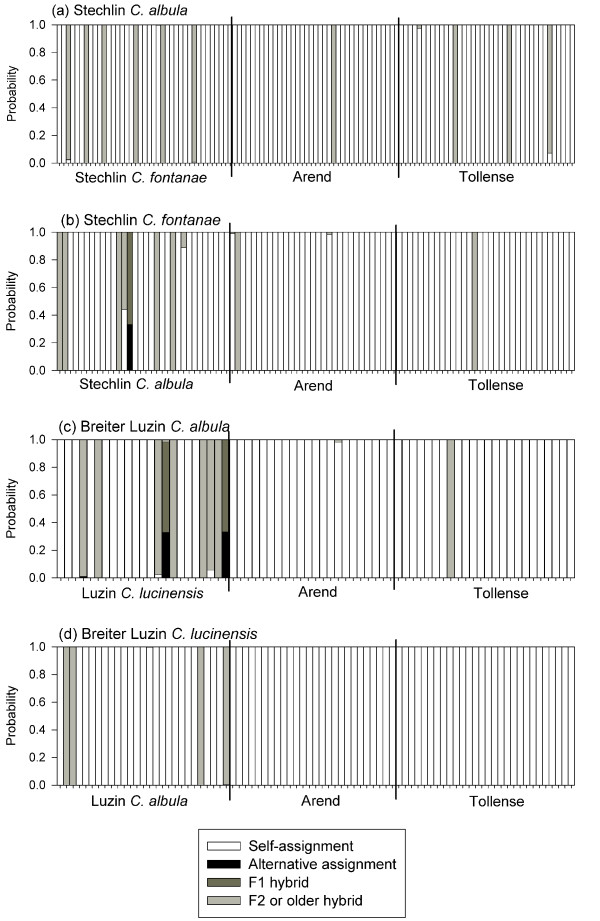
Admixture analysis of hybridization for Lakes Stechlin and Breiter Luzin. Results of the admixture analysis with limited prior probability of hybridization by STRUCTURE for the two sympatric population pairs, Stechlin Coregonus albula (a), Stechlin C. fontanae (b), Breiter Luzin C. albula (c) and Breiter Luzin C. lucinensis (d). Probability of admixture was estimated for the sympatric populations in each lake, and for Lakes Arend and Tollense as potential stocking sources. Hybrids refer either to the first (F1) or the second and older (F2) parental generations.